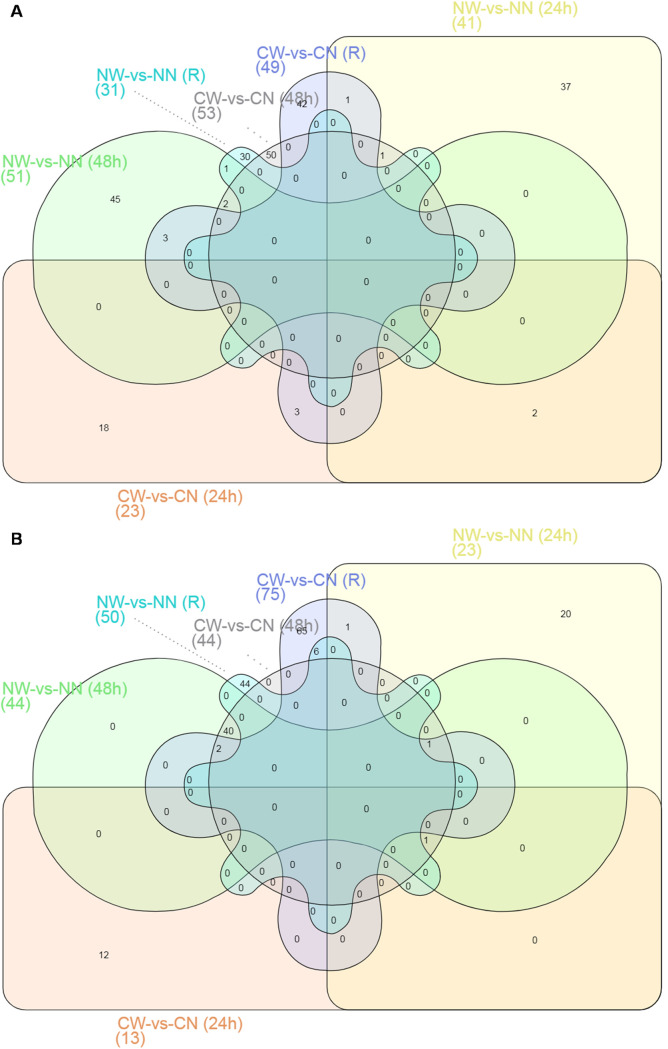
Protein expression profiles in control and nystose-treated rice roots under normal growth conditions and cold stress.A: Venn diagram of the number of DEPs with fold change >1.5 (P<0.05). B: Venn diagram of the number of DEPs with fold change<2/3 (P<0.05). NW-vs-NN (24 h): rice roots that grew at 25°C for 24 h after treatment with water and nystose. CW-vs-CN (24 h): rice roots that grew at 4°C for 24 h after treatment with water and nystose. NW-vs-NN (48h): rice roots that grew at 25°C for 48 h after treatment with water and nystose. CW-vs-CN (48 h): rice roots that grew at 4°C for 48 h after treatment with water and nystose. NW-vs-NN (R): rice roots that grew at 25°C for 7 d after treatment with water and nystose. CW-vs-CN (R): rice roots that grew at 4°C for 2 d and then at 25°C for 5 d after treatment with water and nystose.